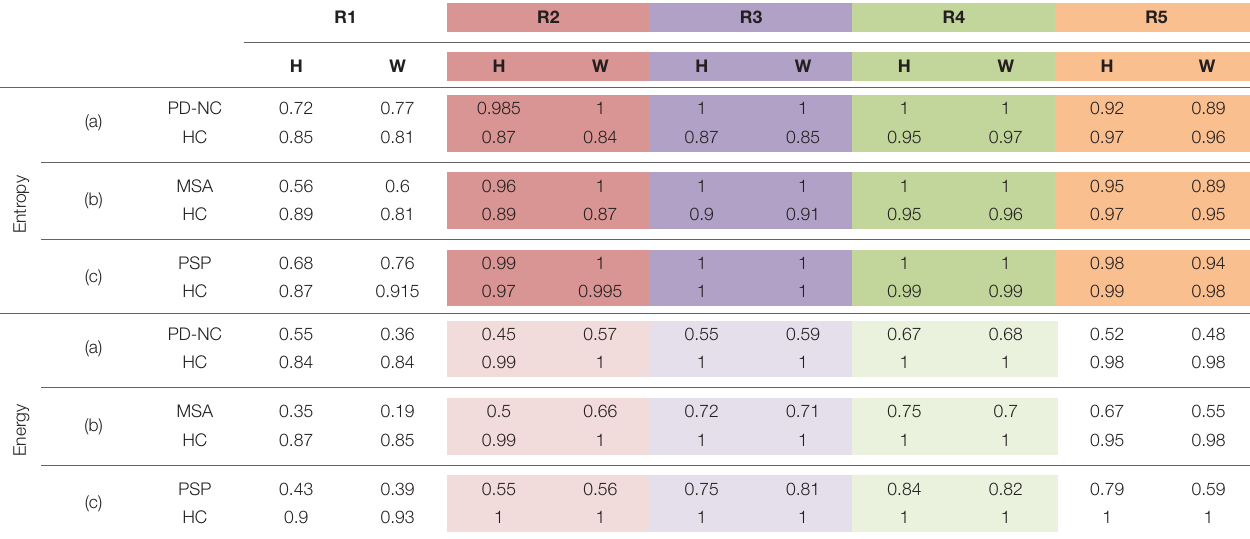
TABLE 3 | The mean Correct Classification Ratio (CCR) values, using the two-class classification accuracies obtained on ROIs separately in each of the five CC sub-regions. R1 R2 R3 R4 R5